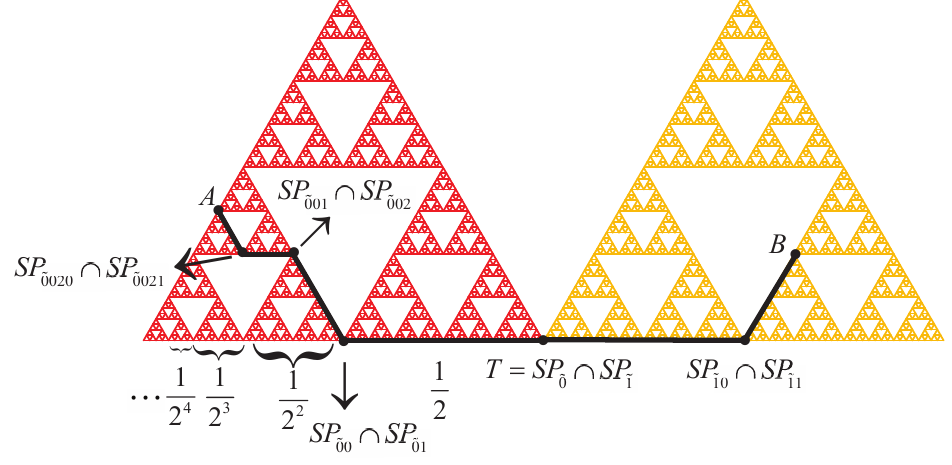
Figure 5. One of the shortest paths between A and B on the Sierpinski propeller for a 0 = (cid:101) 0 and b 0 = (cid:101)